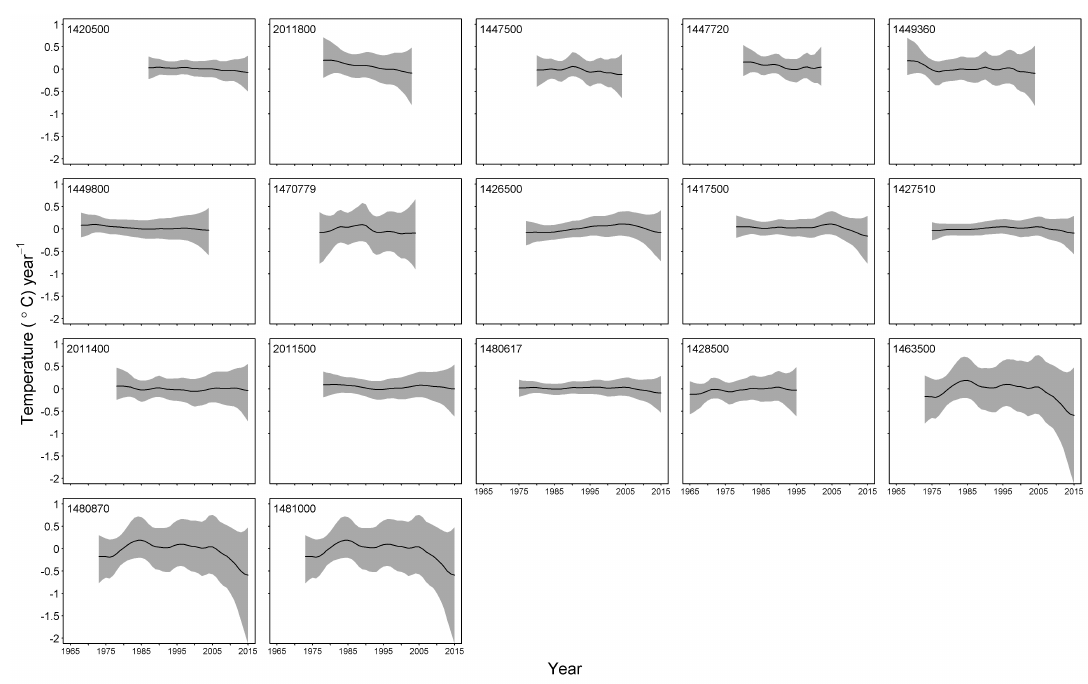
Figure 3. Annual rates of change in winter river water temperature for sites located in the eastern U.S. (see Figure 1 for the site map). Solid lines are posterior means, and shaded areas are 95% credible regions. Numerical codes on each panel correspond to the U.S. Geological Survey gauge ID.